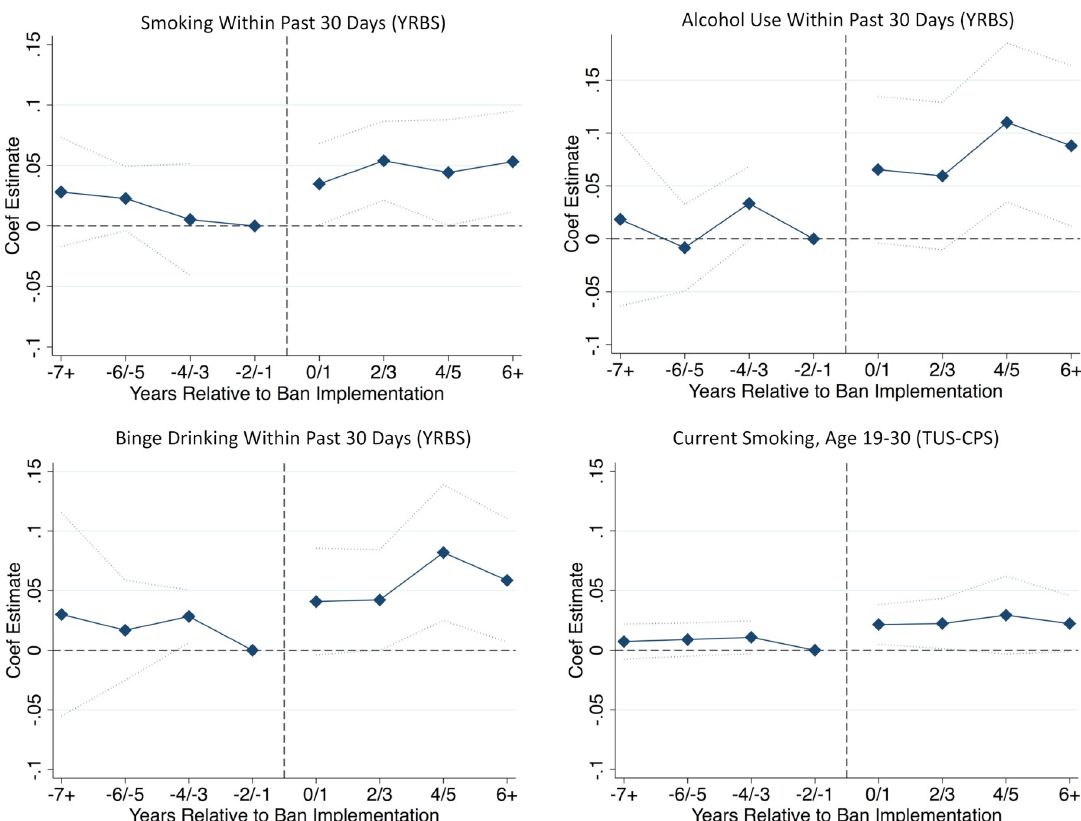
Fig 2. Event study estimates for underrepresented minority respondents. Graphs present event study estimates for underrepresented minority respondents in the YRBS and TUS-CPS. The regression models are identical to those presented in Table 2, except the exposure variable is replaced by a series of binary indicators denoting the timing of interview (or when the individual turned 16 years of age) relative to the policy change. Individuals in states not passing bans were assigned 0 for each of the bins. The 2-year period before ban implementation (event time − 2/ − 1) was denoted as the reference period. The blue diamonds compare the difference in the prevalence of the outcome (“Coef Estimate”), for each point in event time relative to the reference period, between individuals living in states where an affirmative action ban was implemented versus individuals living in states where a ban was not implemented. The dotted blue lines represent 95% confidence intervals, which account for clustering at the state level. There is a confidence interval for the event time period right before ban implementation given that this was denoted as the reference period. Estimates for non-Hispanic White individuals are presented in S2 Fig. TUS-CPS, Tobacco Use Supplement to the Current Population Survey; YRBS, Youth Risk Behavior